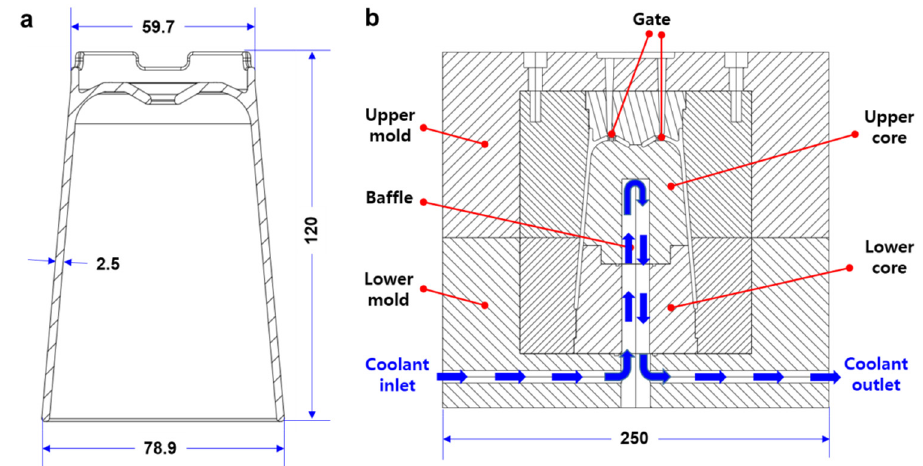
Figure 1. Design of an injection mold for a cup-shaped part: ( a ) Sectional view and dimensions of the cup-shaped part (unit: mm). ( b ) Design of the injection mold with baffle cooling.